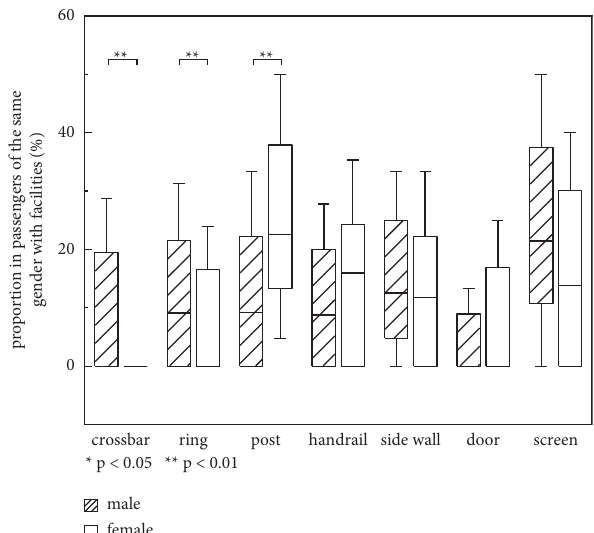
Figure 11: Differences in the use of facilities between different